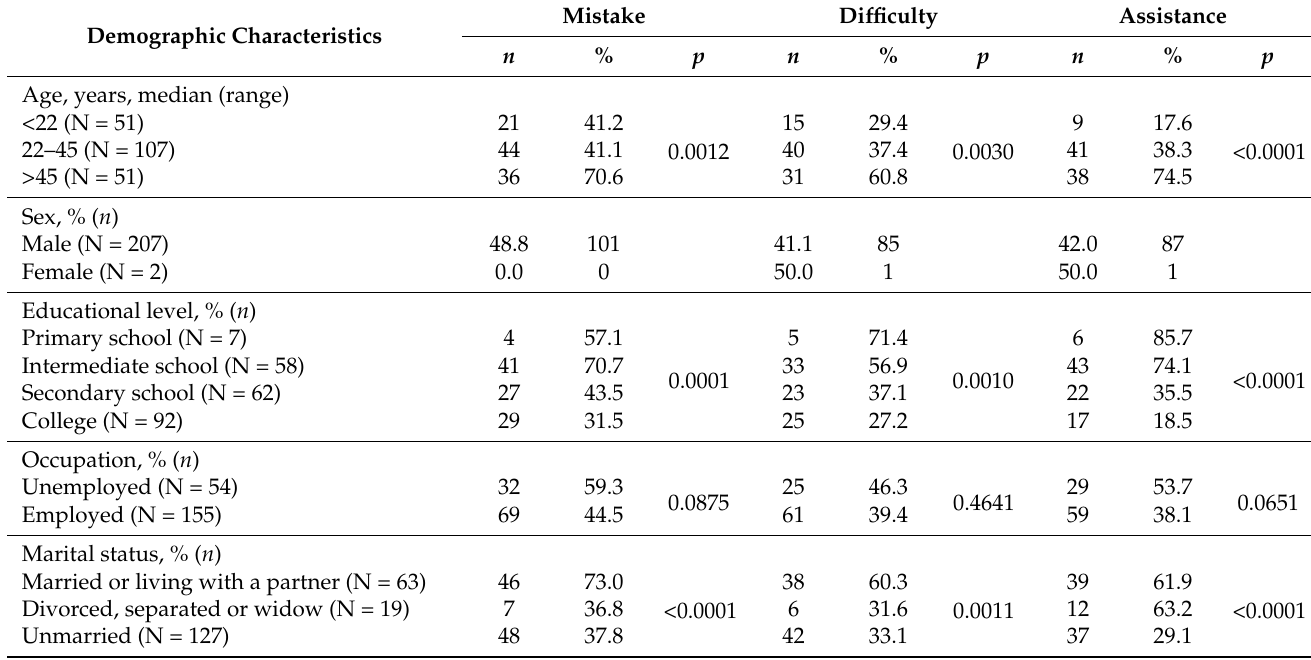
Table 4. Association between personal factors and usability of the hepatitis C virus (HCV) self-test. Demographic